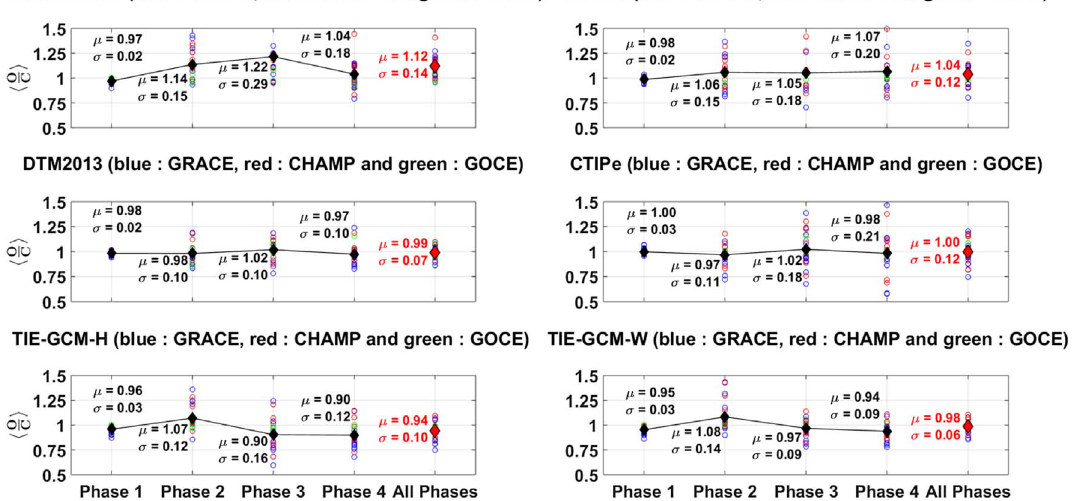
Fig. 4. The mean l and the standard deviation r of the 24 mean density ratios, per phase (black) and overall (red), using data from three satellites.